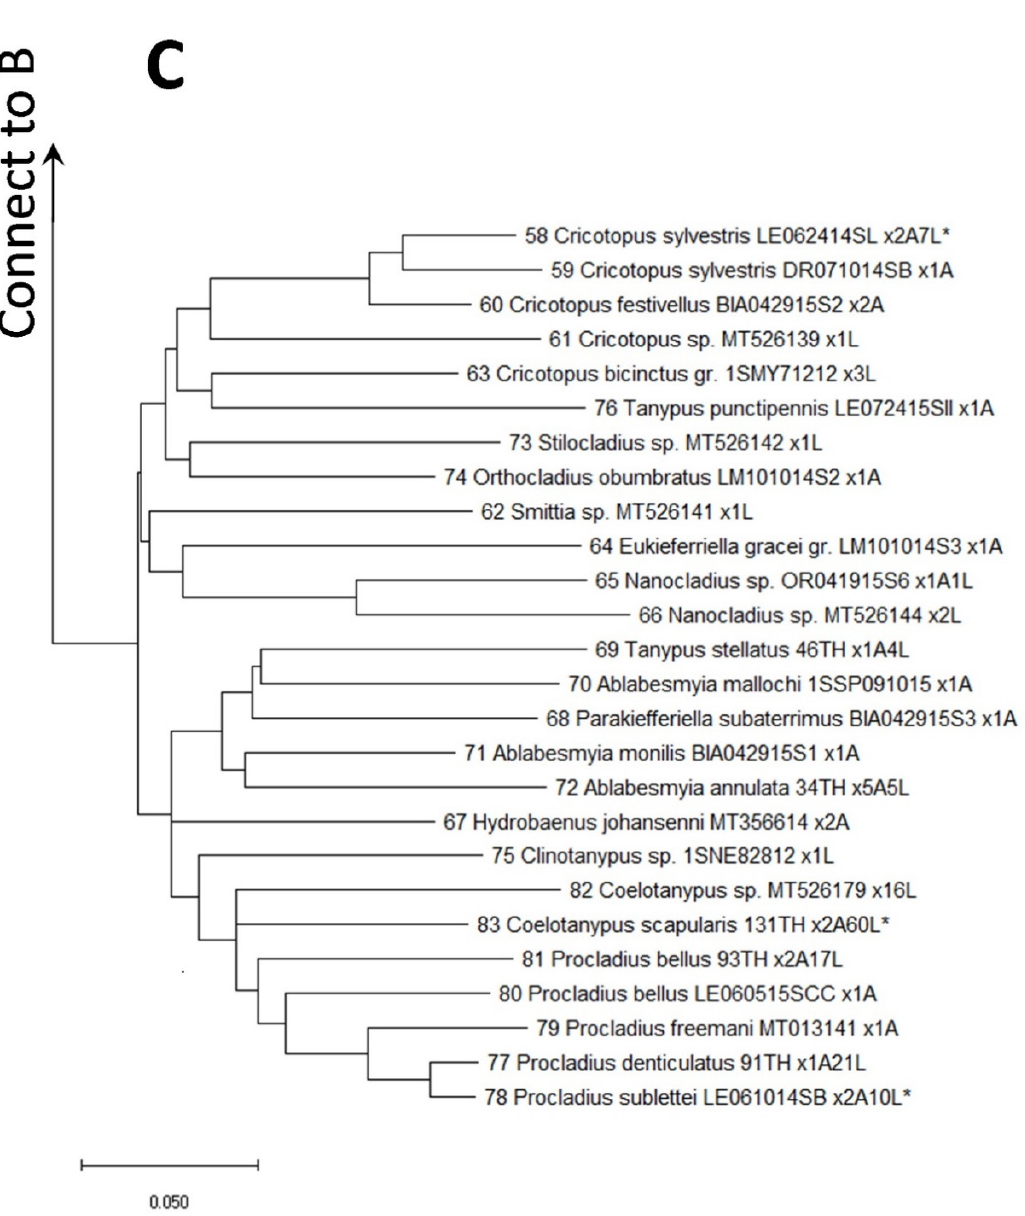
Figure 2. Curated consensus chironomid reference tree. The names on each branch represent the consensus of clusters of up to 71 specimens, taking into account criteria of sequence length, most specific taxon identification, and consistency with identification with the other members of the cluster. Due to the large size of the tree, the full tree is shown in three parts ( A – C ), of which the major constituents are ( A ) tribe Tanytarsini, ( B ) tribes Chironomini and Pseudochironomini, plus several Dicrotendipes spp. and ( C ) subfamilies Tanypodinae and Orthocladinae. See Figure S1 to for larger view of full tree seen in ( A ). Naming convention for each branch: Lab ID number, genus (XXX sp.) or species (XXX yyy), GenBank accession ID or RamLab ID (if not already uploaded), x number of adults ( A ) and number of larvae (L) used for branch consensus, * shown if a specimen has been removed or name revised due to non-consensus identification or other comment about the branch (see Table S1). The lines in the image at the left of A shows how the entire tree was split into three parts.